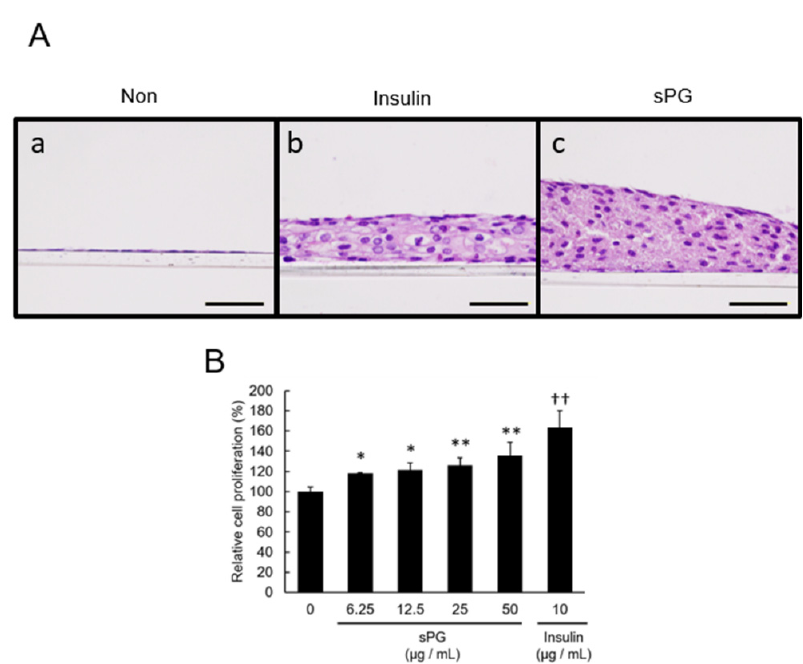
Figure 4. Formation evaluation on chondrogenic differentiated ATDC5 cells of sPG. ( A ) Histological observation of chondrogenic differentiated ATDC5 cells. Untreated cells ( a ) or cells treated with sPG (50 μ g/mL) ( c ) or insulin (10 μ g/mL) ( b ) were cultured on cell culture insert under DME/F12 medium containing 5% FBS at 37 °C in a humidified atmosphere of 5% CO 2 in air for 21 days from post-confluence. Histological sections of cultured cells were stained with hematoxylin and eosin observed using phase ‐ contrast microscopy. ( B ) Cell proliferative effect of sPG in chondrogenic differentiated ATDC5 cells. Proliferative ability of untreated cells or cells treated with sPG 6.25–50 μ g/mL or insulin 10 μ g/mL was assessed by the WST ‐ 8 assay. These data are presented as the mean ± S.D. of three independent experiments. Significant differences of sPG show * p < 0.05; ** p < 0.01 vs . 0 μ g/mL as control, Dunnett ′ s test. Signi fi cant di ff erences of insulin show †† p < 0.01 vs. 0 μ g/mL as control, Student ′ s t ‐ test. Scale Bar = 100 μ m.